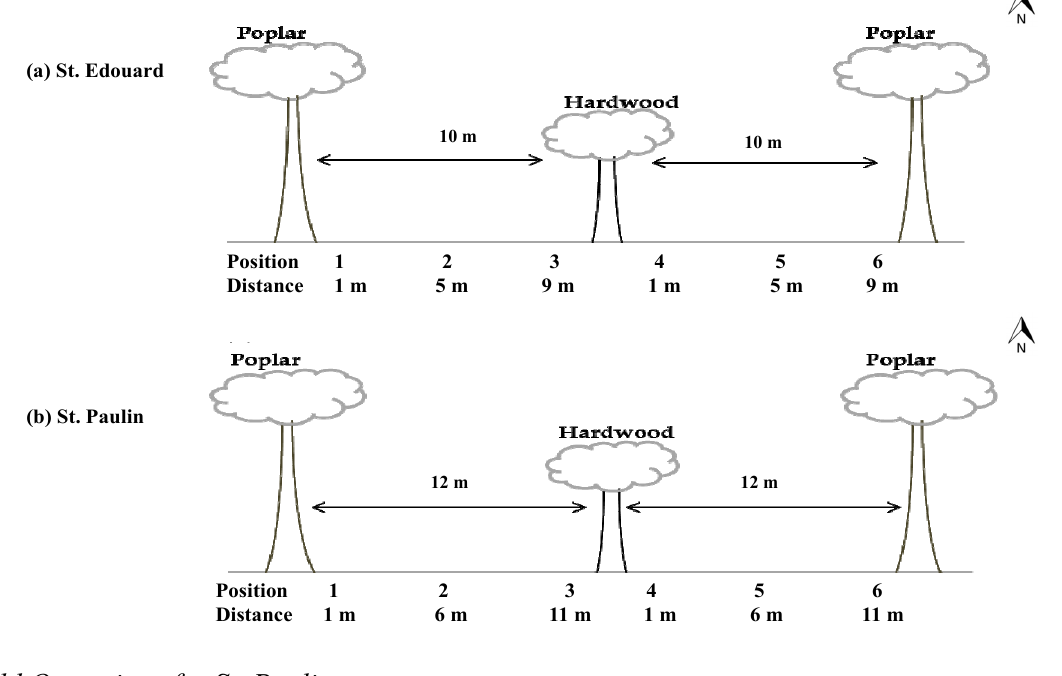
Figure 2. Sampling positions for the experimental tree-based intercropping systems at ( a ) St. Edouard and ( b ) St. Paulin, southern Quebec, Canada. The sampling position (1–6) and corresponding distance from trees in meters (m) within the tilled alleys are